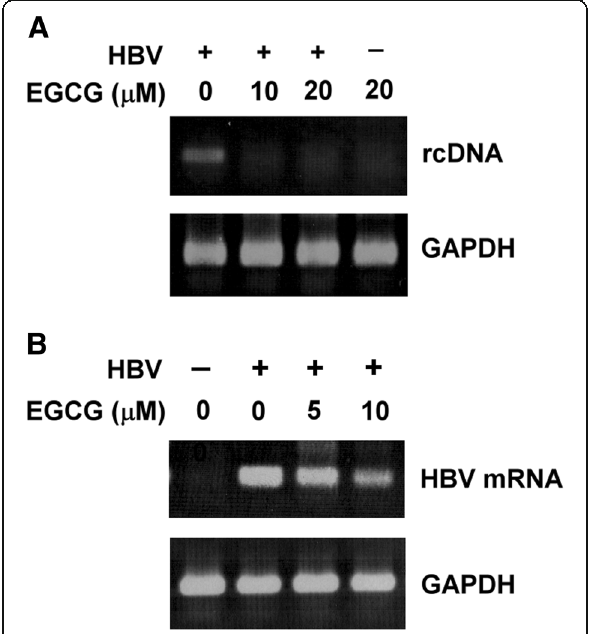
Fig. 1 EGCG inhibited HBV infection. DMSO-differentiated HuS-E/2 cells were infected with HBV for 20 h in the presence of EGCG and incubated for an additional 7 days. Nucleic acids were extracted from the cells and amplified to detect the presence of HBV rcDNA ( a ) and HBsAg mRNA ( b ), to evaluate the infection